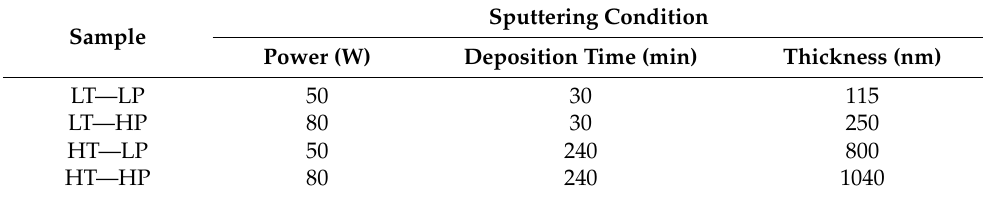
Table 1. Magnetron sputtering conditions for the Nd-doped La 3 NbO 7 thin films, where LT stands for “Low Thickness”, HT stands for “High Thickness”, LP stands for “Low Power” and HP stands for “High